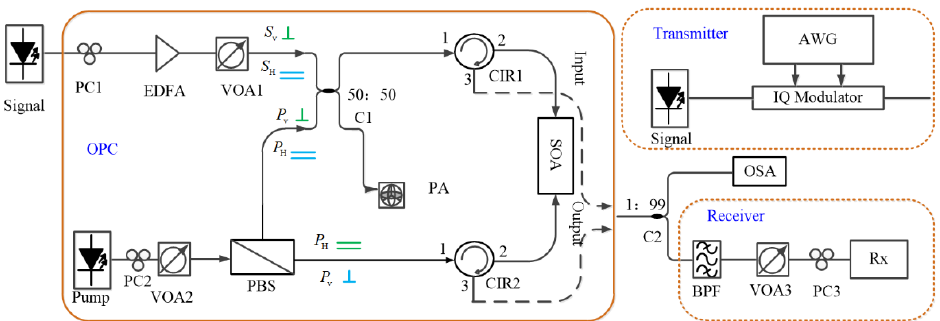
Figure 7. Experiment setup of the nonlinear bidirectional SOA-based OPC process.